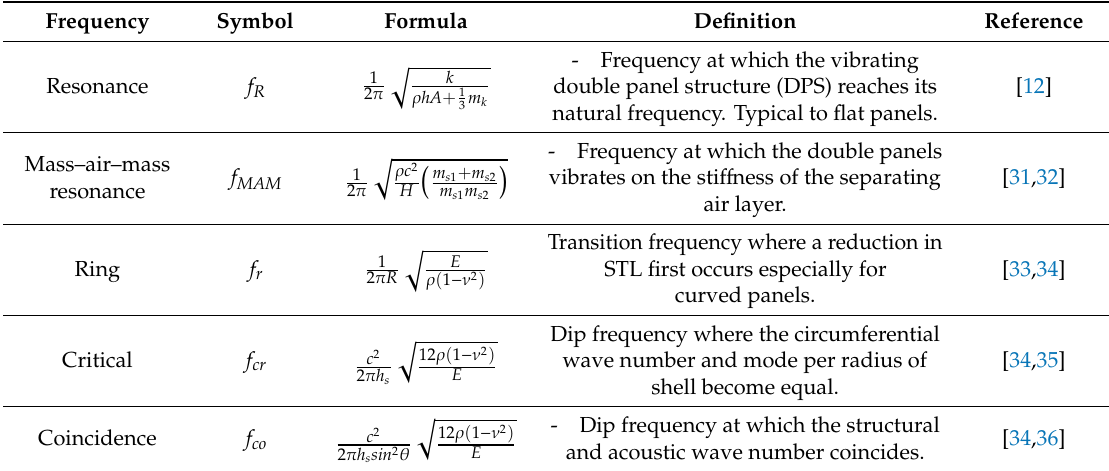
Figure 1b. At this frequency, the longitudinal wavelength equals the circumference of the structural element [27]. The next observed frequency for the cylindrical or curved shell is the critical frequency ( f ) . This is the dip frequency where the circumferential wave number and mode order divided by cr the radius of shell are equal. The expressions of the critical dip frequency of DPS have been given by Blaise et al. [26]. The dip frequency that is common to flat, cylindrical or curved DPS is the coincidence frequency ( f co ) . At this frequency, the wavelength of the trace velocity of the acoustic wave becomes equal to the bending wave velocity of the DPS. Moreover, the coincident frequency approaches the critical frequency as the incident angle ( θ ) becomes 90 degrees. Table 1 gives the formulas used for calculating these frequencies at di ff erent regions. From Table 1, the symbols E , R s , ρ and ν represent Young’s modulus, radius of the cylindrical shell, density and Poisson ratio, respectively. While h s and c represent the thickness of the cylindrical shells and velocity of flow in the medium, respectively; the symbols k , h , A , m k , m s 1 , m s 2 and H are sti ff ness, thickness, area of the piezoelectric patch of resonator, mass of the equivalent spring, surface mass densities of the two panels and distance between the two panels, respectively. Also, these frequencies are key indicators typically used by researchers to analyze the vibro-acoustic response of double panels or shell structures [28–30]. Table 1. Formulas and definitions of frequency terms commonly used at di ff erent regions of sound transmission loss (STL) curves. Symbol Formula